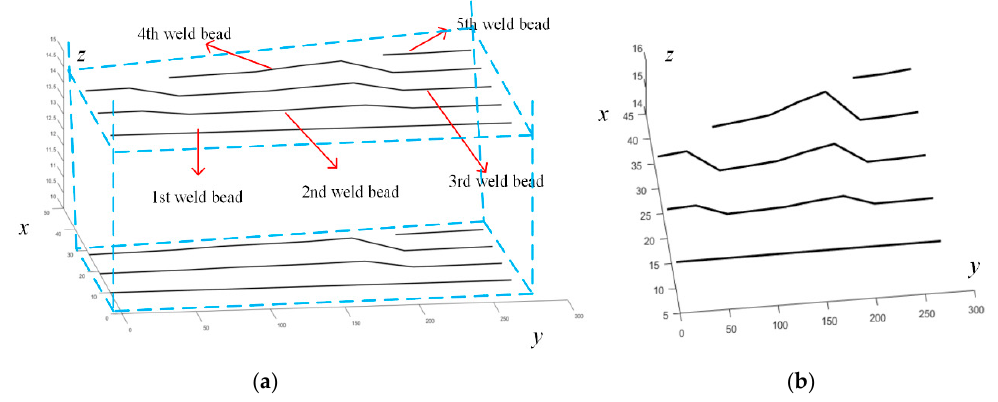
Figure 20. ( a ) Simulation results of the first two layers welding path (the blue part is the groove outline); ( b ) Simulation results of the path generation of separate second layer.